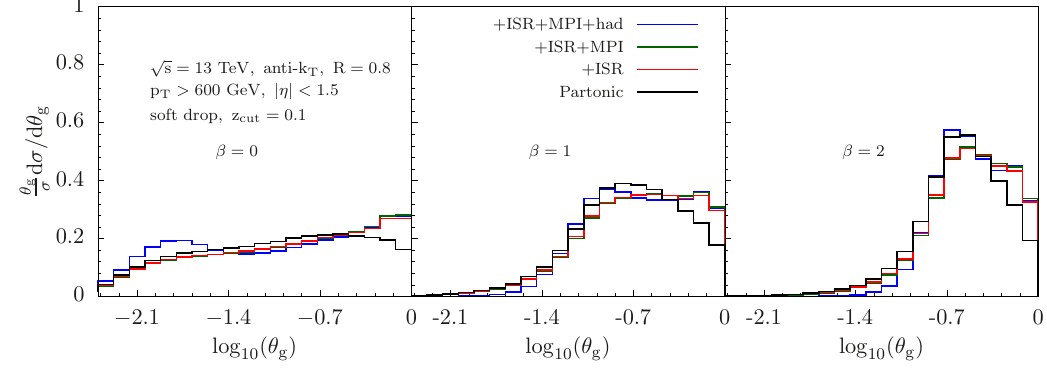
Figure 7 . Pythia 8 results [88] for the normalized soft drop groomed jet radius (cid:18) g for the same kinematics as in (cid:12)gure 6 above. We separately show the purely partonic result (black), including initial-state radiation (red), multi-parton interactions (green) and hadronization corrections (blue).